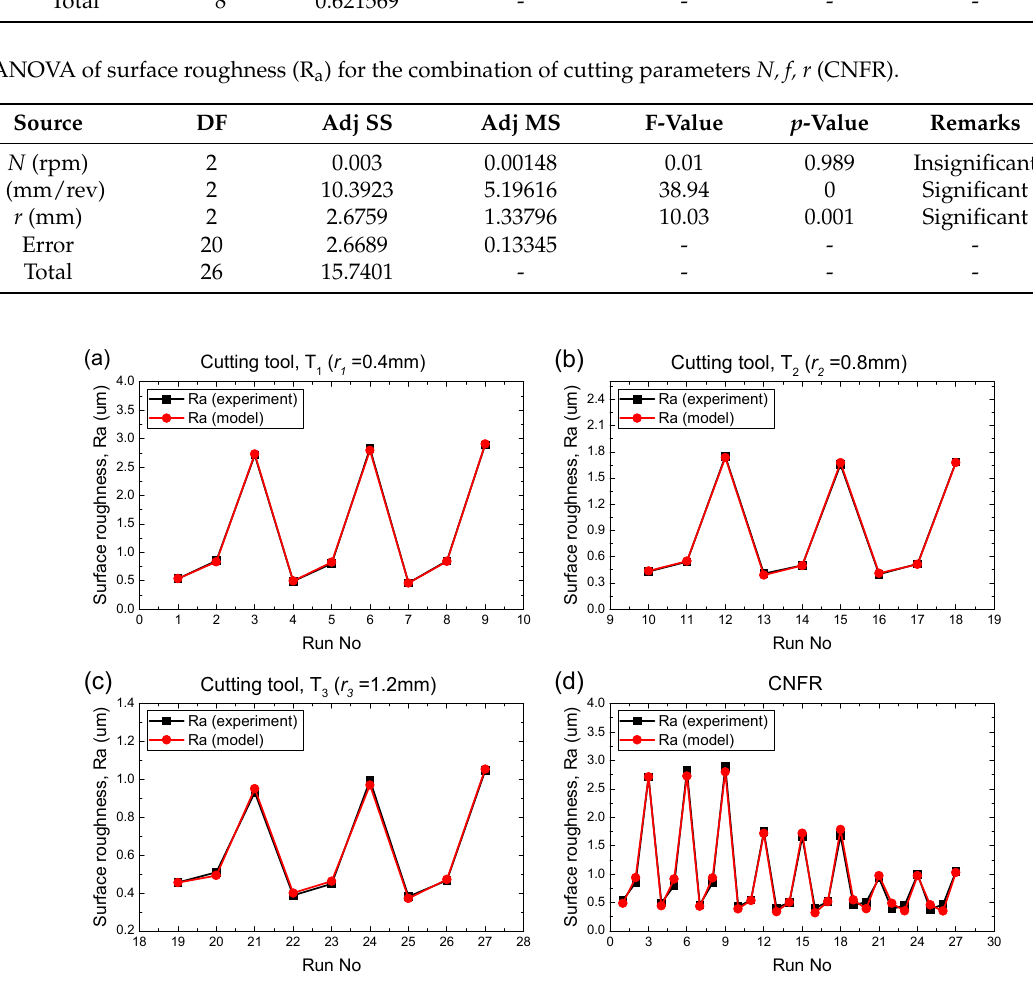
Figure 4. Comparison between values of experimental measurement and the prediction model for surface roughness (R a ) using the following three different tool nose radii: ( a ) r 1 , ( b ) r 2 , ( c ) r 3 and ( d ) CNFR.